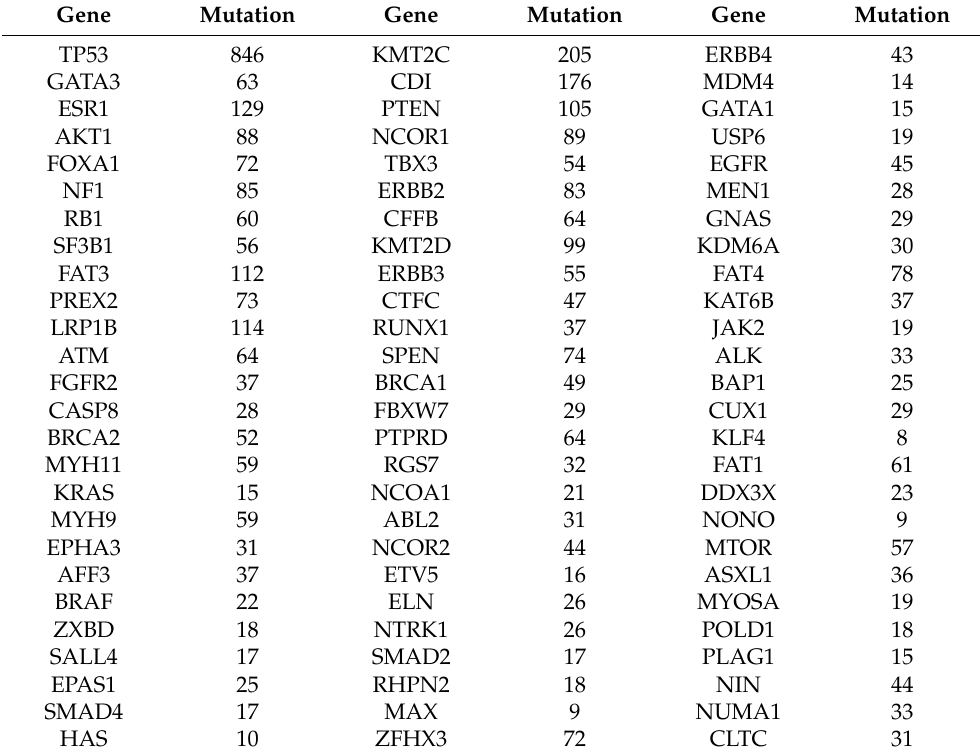
Table 5. Symbols of genes involved in breast adenocarcinoma. Gene Mutation Gene Mutation Gene Mutation